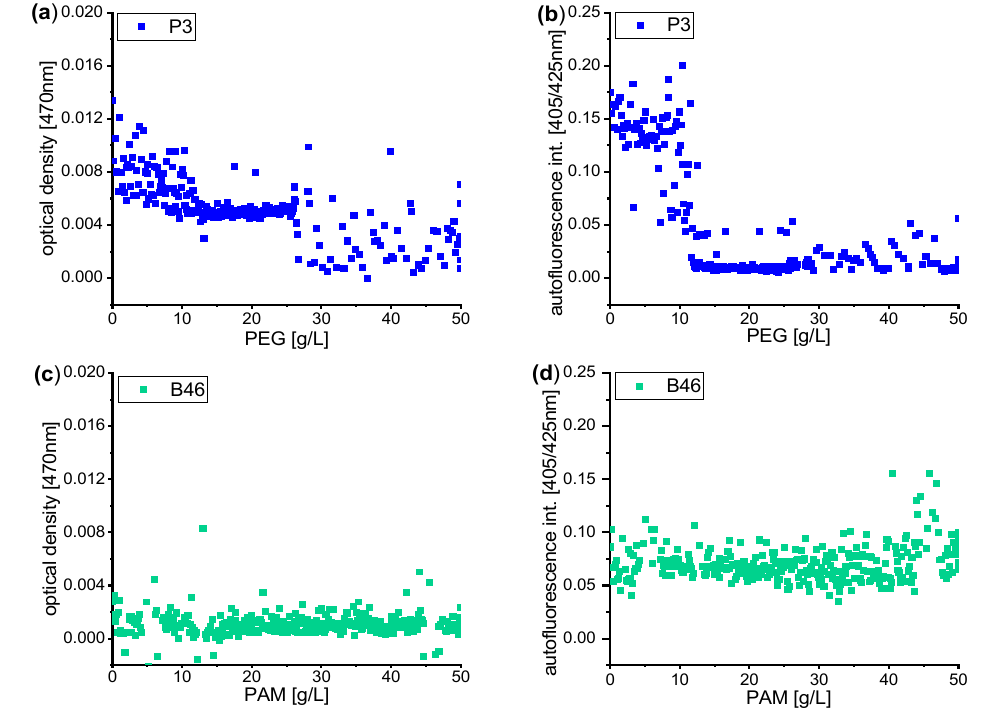
Figure 4. Effect of polymers on soil sample P3 and B46 by the dose-response function in dependence of PEG ( a , b ) and PAM ( c , d ) in AM medium: microphotometric signal ( a , c ) and fluorometric signals ( b , d ). Each dot represents the optical density/fluorescence intensity for an individual droplet.